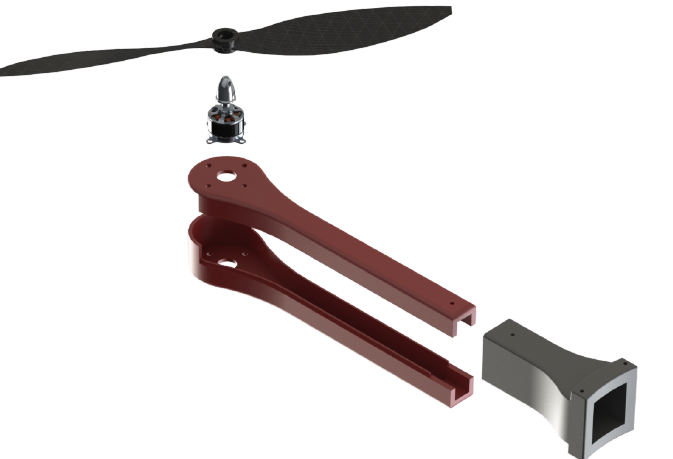
Figure 6. Graphic rendering of the arm assembly. The support is colored in gray; the upper and the lower elements are those in